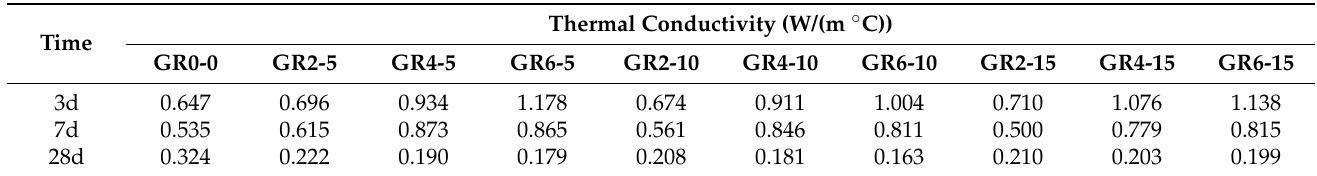
Table 2. Thermal conductivity of Reference specimen mortar and fibers